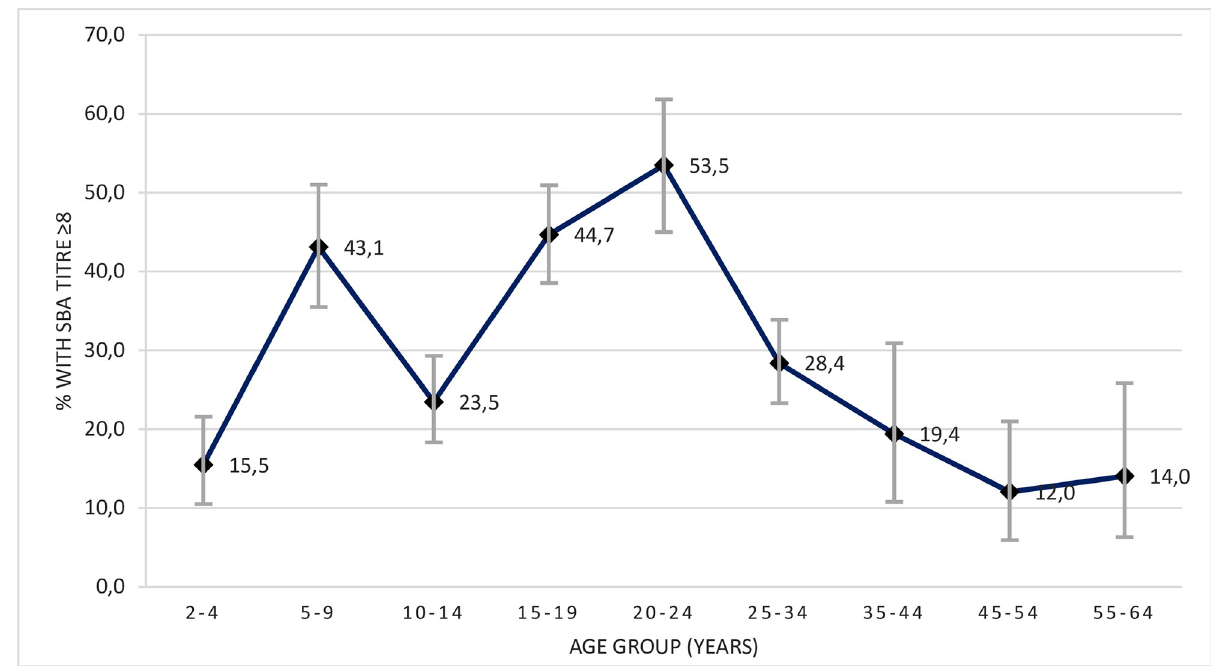
Fig 1. Percentages of serum samples with protective ( � 8) SBA titres and 95%CI, by age group, in Portugal, 2015/2016.